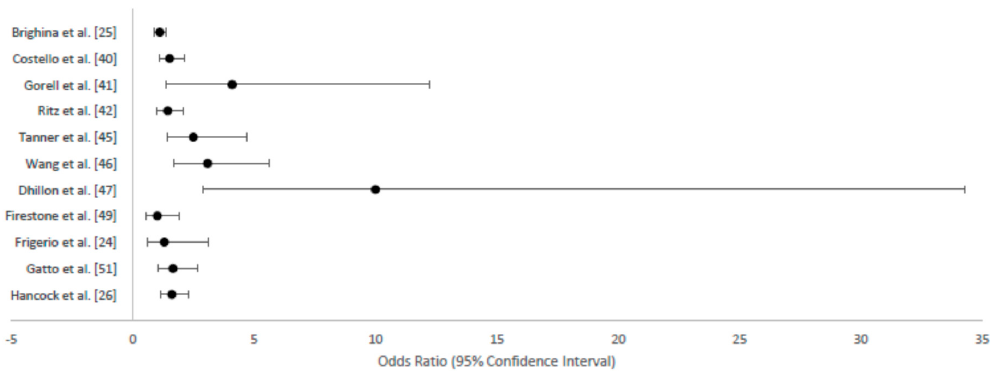
Figure A2. Forest Plot for Studies from the U.S. Int. J. Environ. Res. Public Health 2017 , 14 , 640